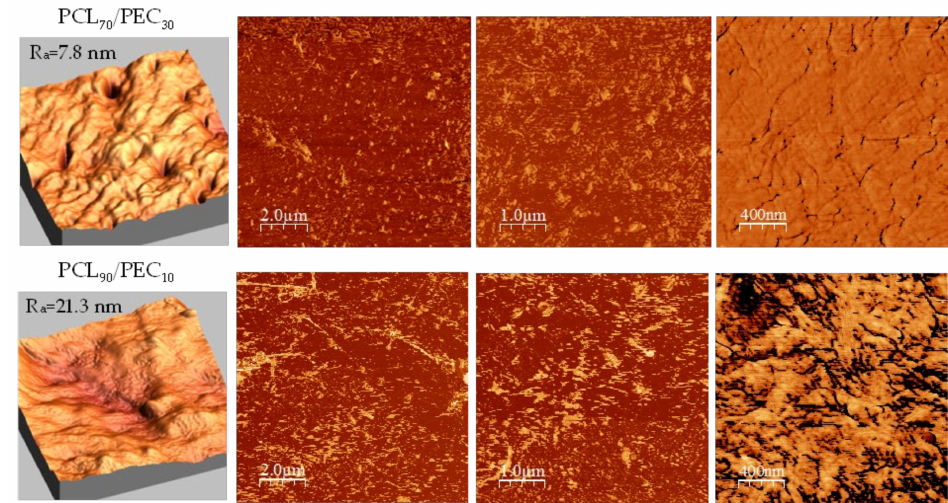
Figure 4. AFM morphology and phase images of PCL 70 /PEC 30 and PCL 90 /PEC 10